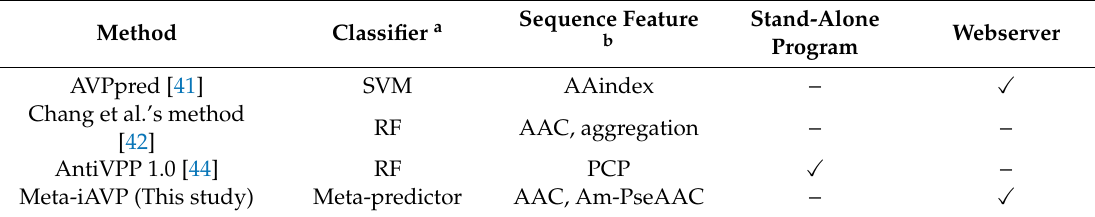
Table 1. Summary of existing methods for predicting antiviral